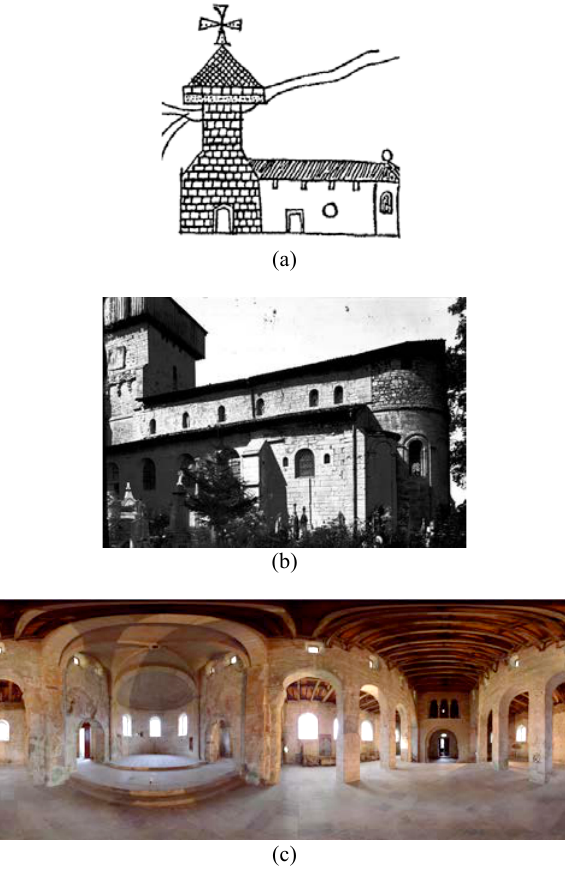
Figure 1. Site under study: (a) South elevation (1689); (b) Photograph of the exterior of the church (Enlart, 1904); (c) Panorama of the interior